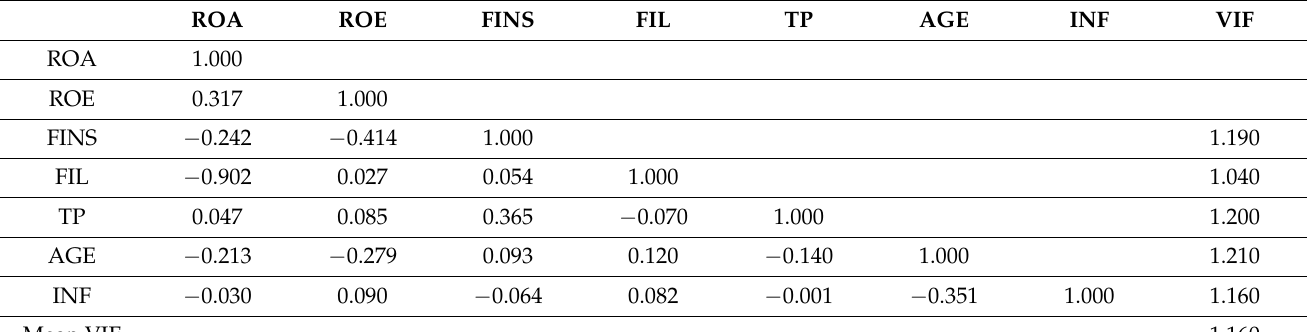
Table 5. Results of correlation matrix and VIF test.